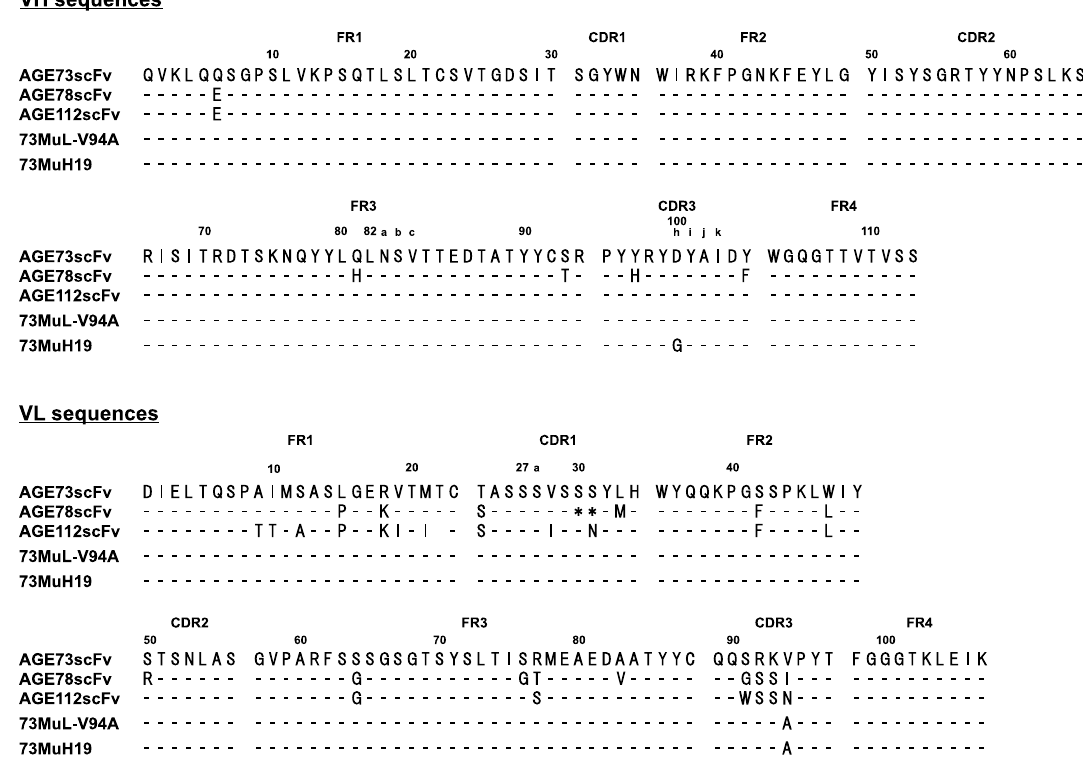
Figure 4. Immunohistochemical staining of human atherosclerotic lesion. Positive reactions were seen for the accumulation of GA-pyridine (brown). The sections were treated with anti-GA-pyridine monoclonal antibody, 2A2 ( A ) and AGE73scFv ( B ), respectively.